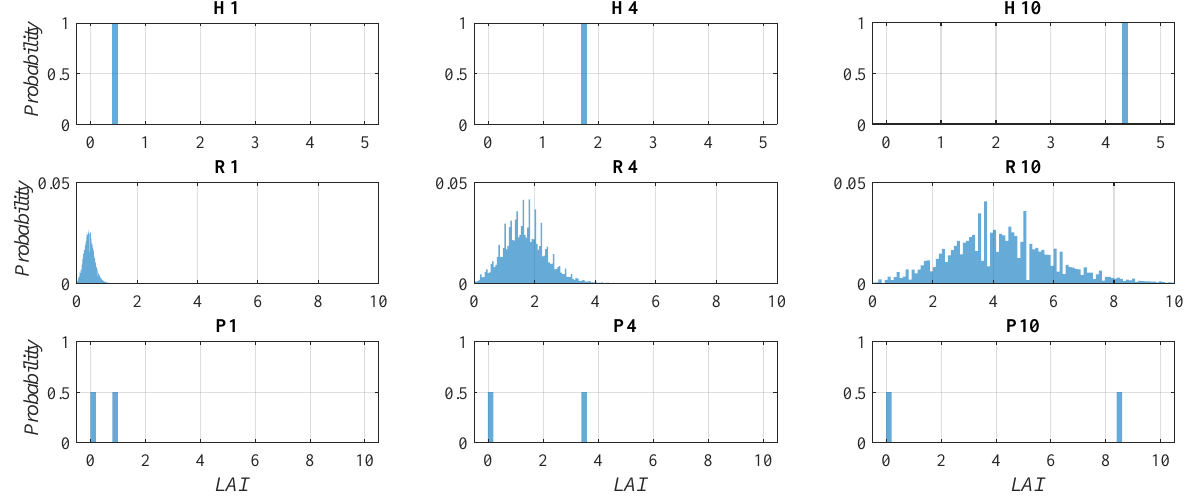
Figure 6. Normalized probability distributions of the LAI for all forests